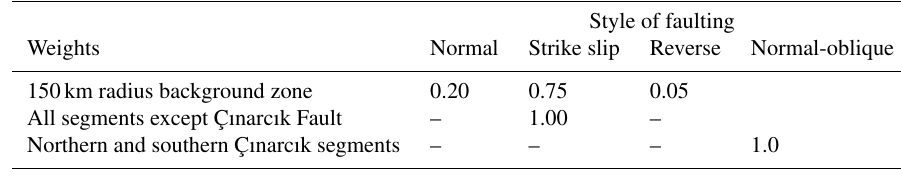
Table 3. Aleatory variability for style of faulting in the background zone.